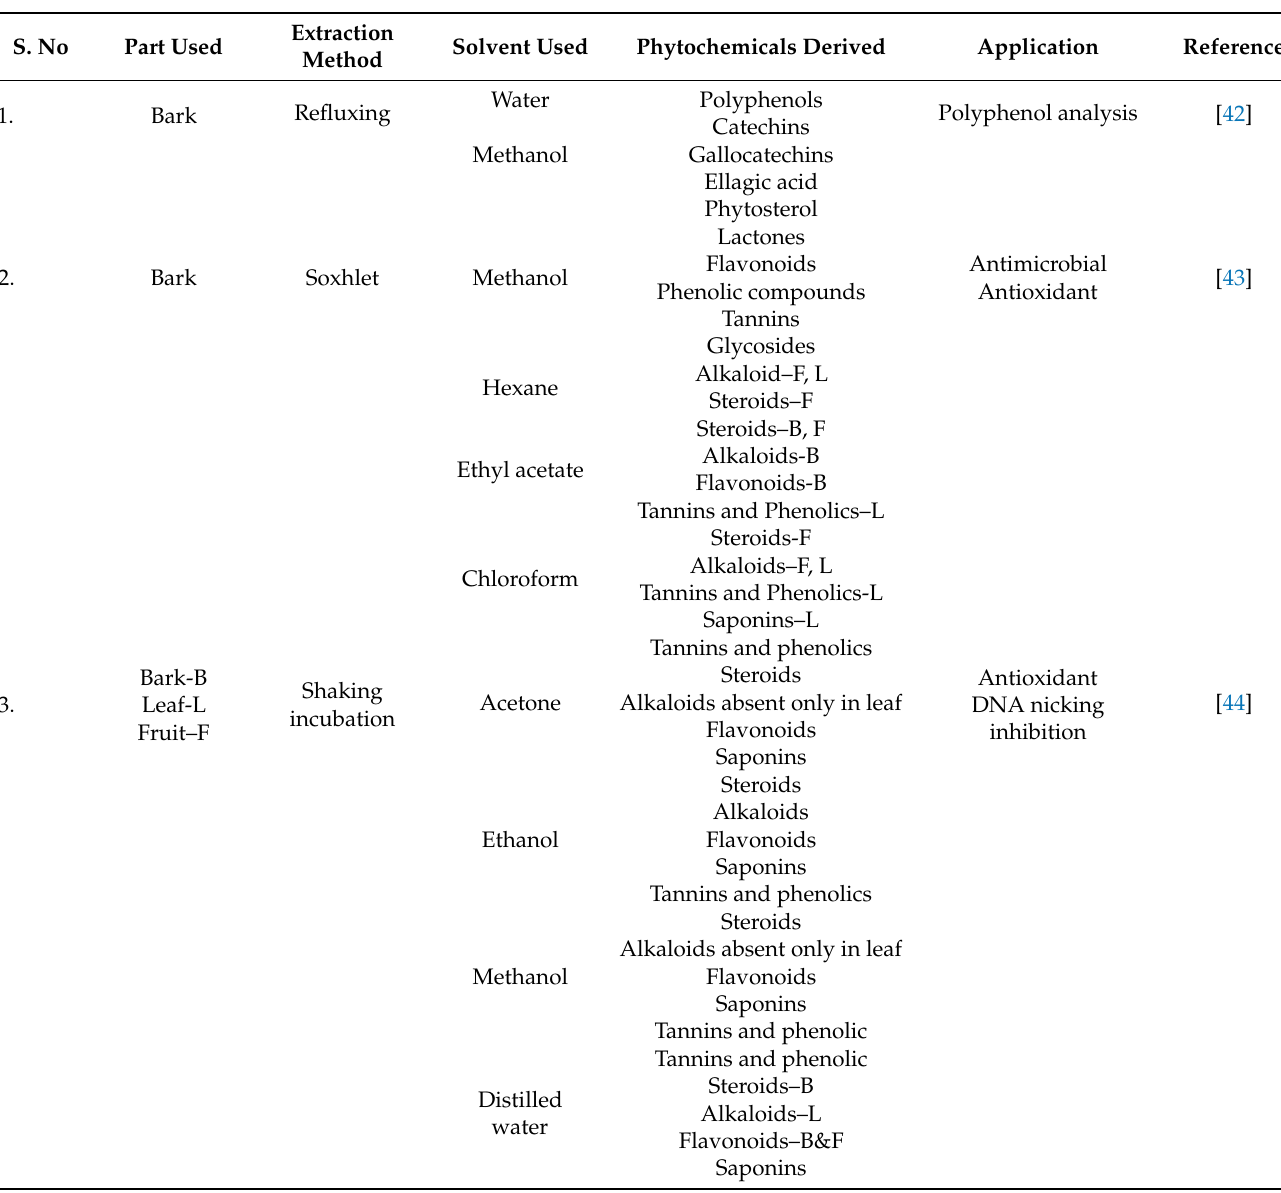
Table 1. Summary of the phytochemicals derived from various parts of TA plant, their extraction methods, and their biomedical